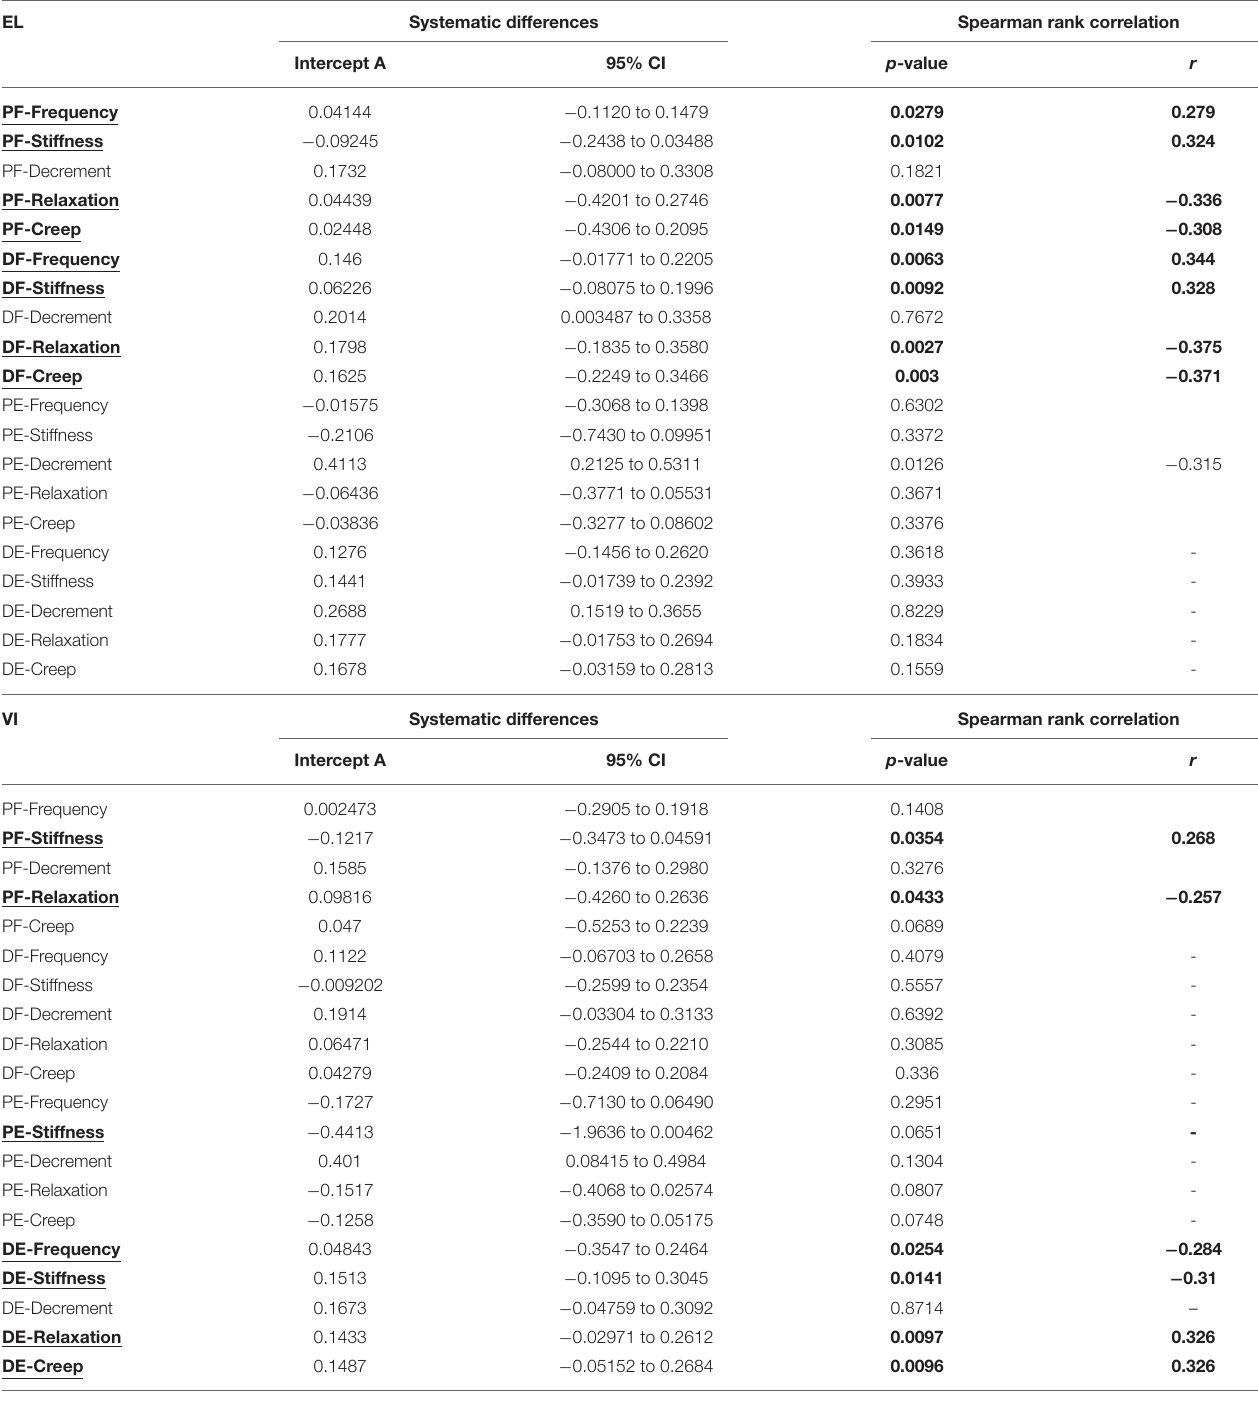
TABLE 2 | Results of Passing and Bablok linear regression.